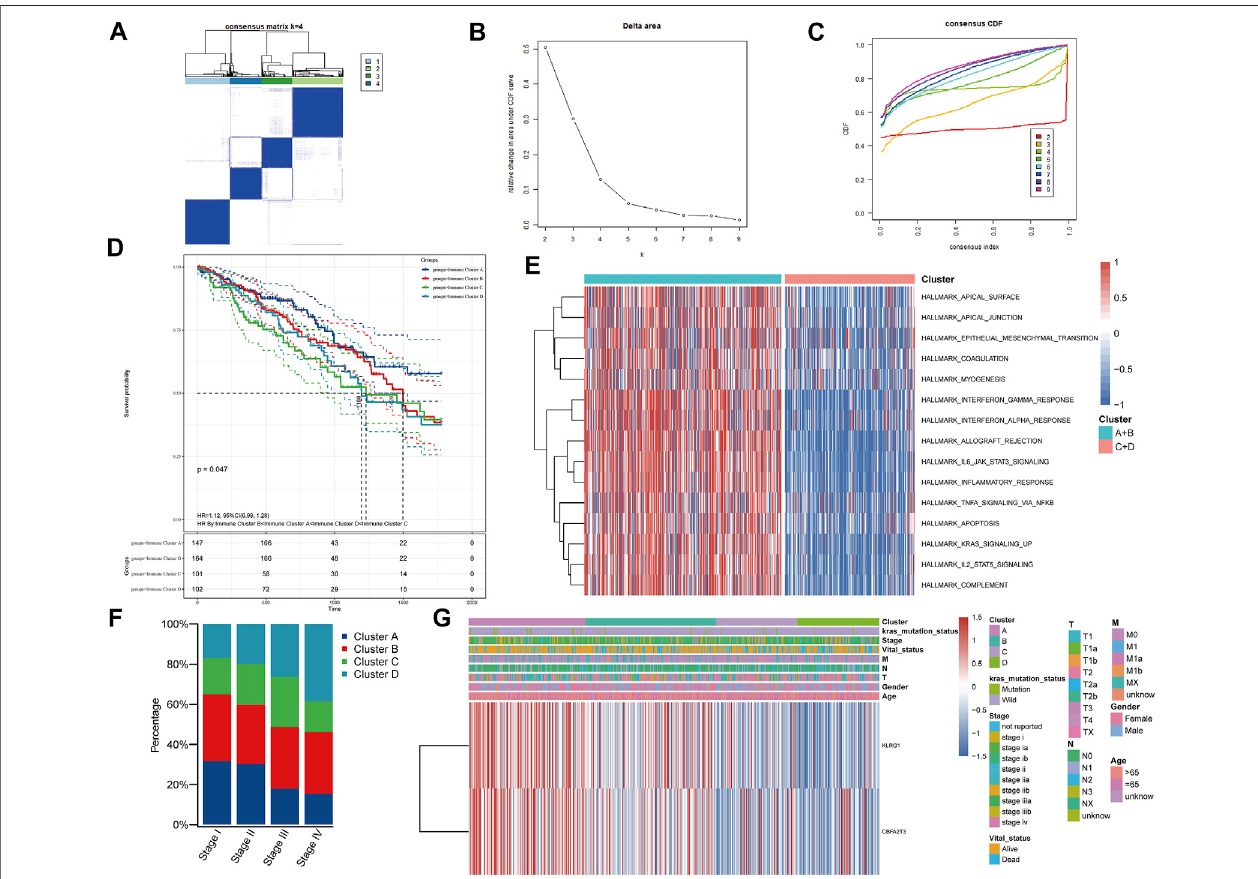
FIGURE 4 | Identi fi cation of immune clusters in patients with lung adenocarcinoma. (A – C) Patients with lung adenocarcinoma were divided into four immune clusters according to the expression of immune-related genes. (D) Survival analysis of patients with different immune clusters. (E) GSVA enrichment analysis of cancer Hallmarks in patients with different immune clusters. (F) Distribution of immune clusters in patients with different stages. (G) Heat map of tumor antigen expression and clinical parameters.